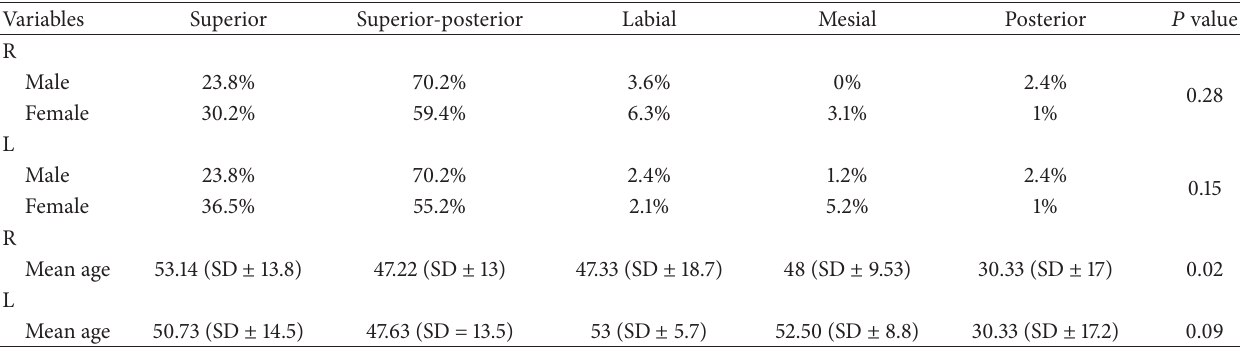
Table 2: The frequency (%) of the opening direction of mental foramen for gender and mean age in the right and left sides. Variables